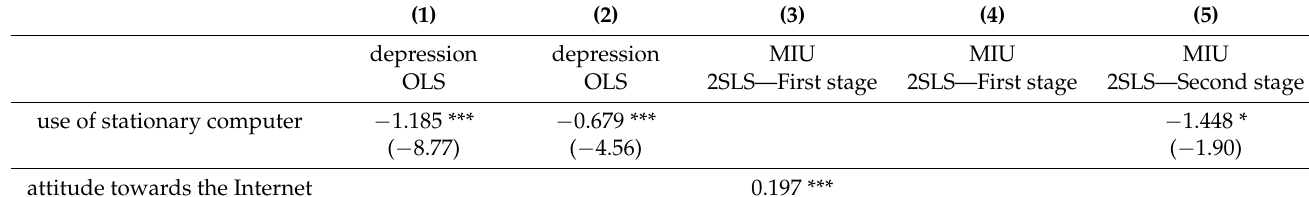
Table 12. Benchmark instrumental variable regression results.